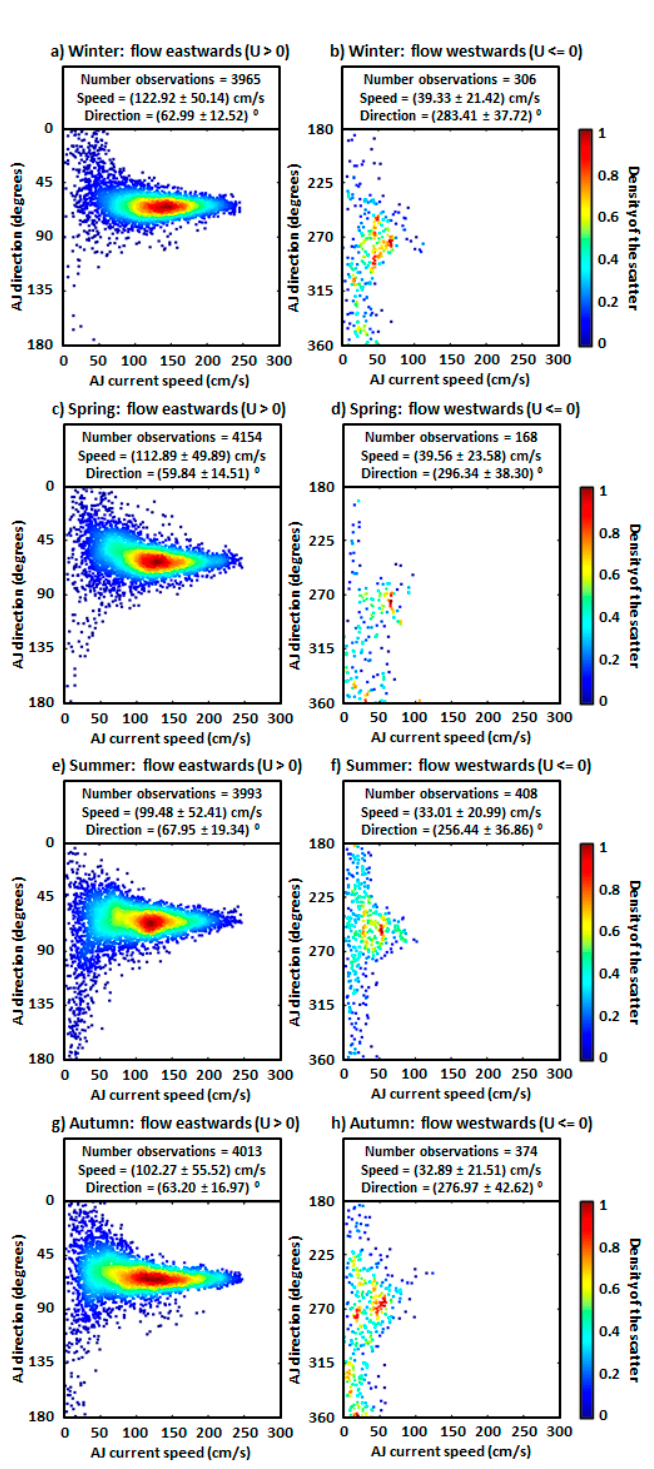
Figure 4. Seasonal scatter plots of hourly Atlantic Jet (AJ) current direction (angle measured clockwise from the North) versus speed estimations at the midpoint of the selected transect, with AJ flowing eastwards (left) and westwards (right): ( a , b ) Winter (JFM); ( c , d ) Spring (AMJ); ( e , f ) Summer (JAS); ( g , h ) Autumn (OND). Quarterly mean and standard deviation values of both AJ speed and direction are provided. Analysis performed for a 2-year period (2016–2017).